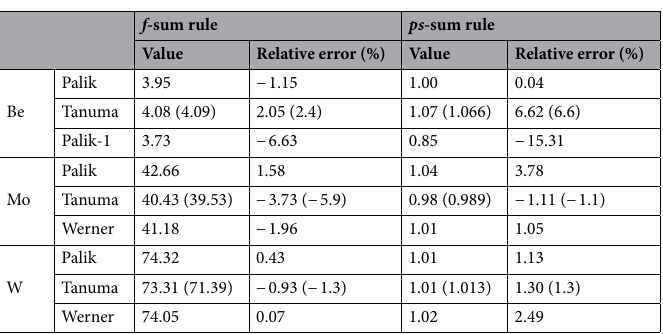
f -sum rule ps -sum